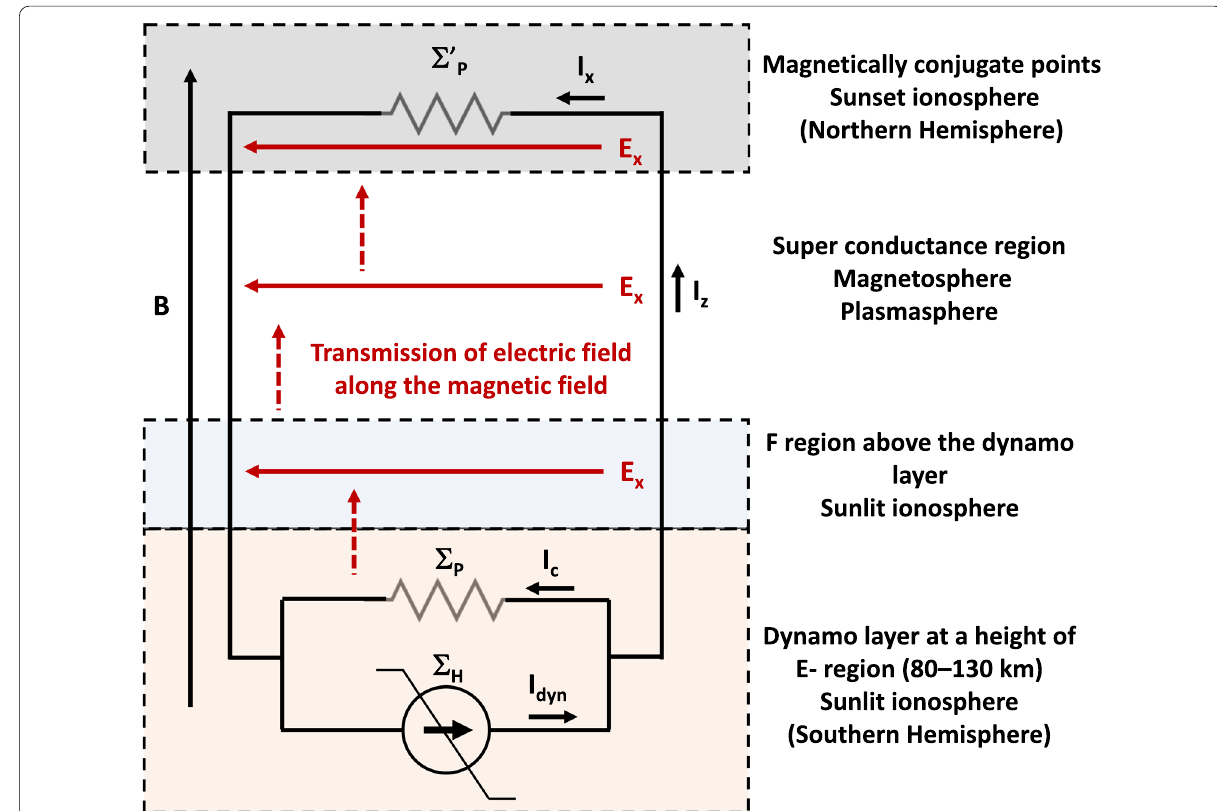
Fig. 7 Equivalent electric circuit of magnetosphere–ionosphere current system connecting between the sunlit Southern Hemisphere and the sunset Northern Hemisphere. The red arrows indicate the dynamo electric field mapped in the F region of the ionosphere and in the magnetically conjugate